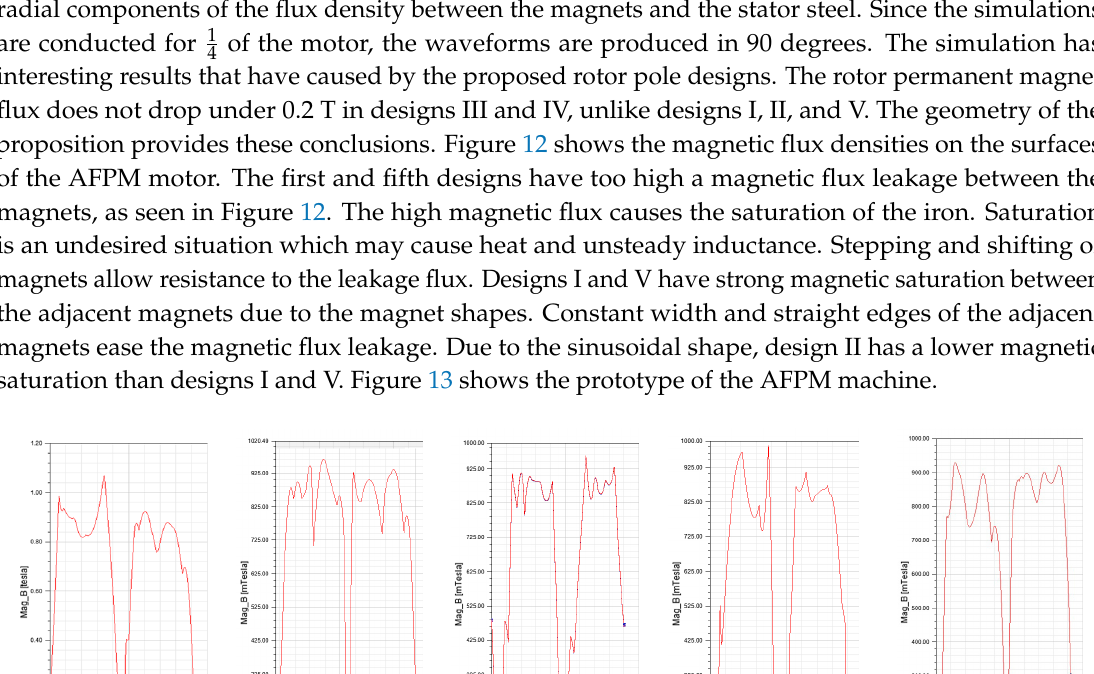
Figure 10. Back EMF results.